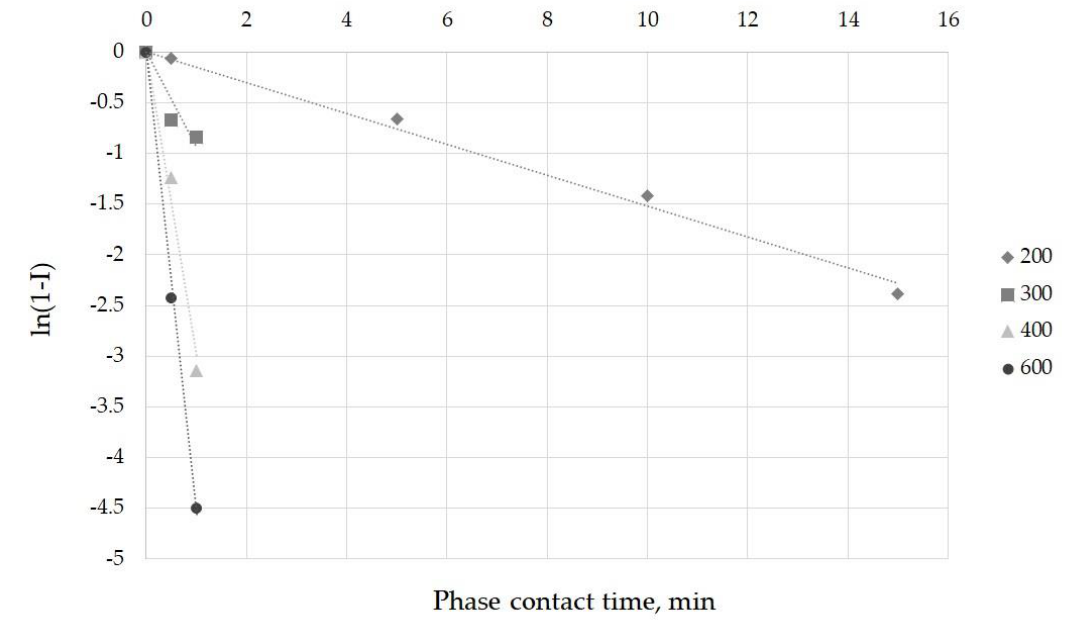
Figure 3. The logarithmic dependences of the degree of approaching to equilibrium on the stirring rate at a temperature of 300 K.